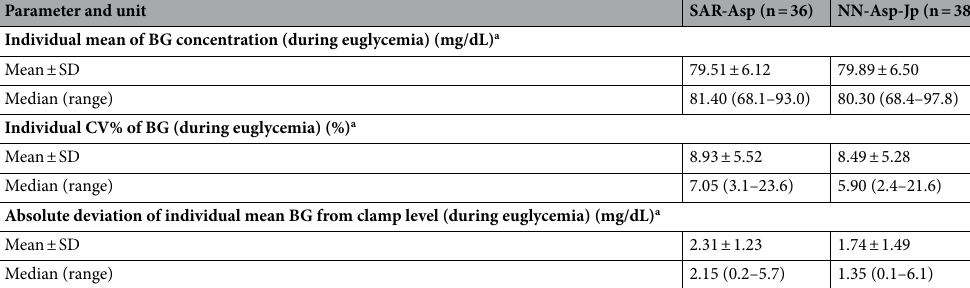
Table 3. Performance of clamp during euglycemia. BG blood glucose, CV coefficient of variation, SD standard deviation. a Euglycemia starts with dosing and ends with the last value of the smoothed BG concentration curve at or below the predetermined target blood glucose concentration for each individual subject, as described in the methods. Clamp level (BG target) for each subject was 5 mg/dL (0.28 mmol/L) below the subject’s baseline